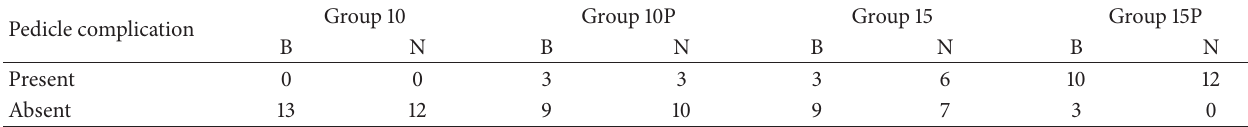
Table 3: Distribution of results according to the type of screws.